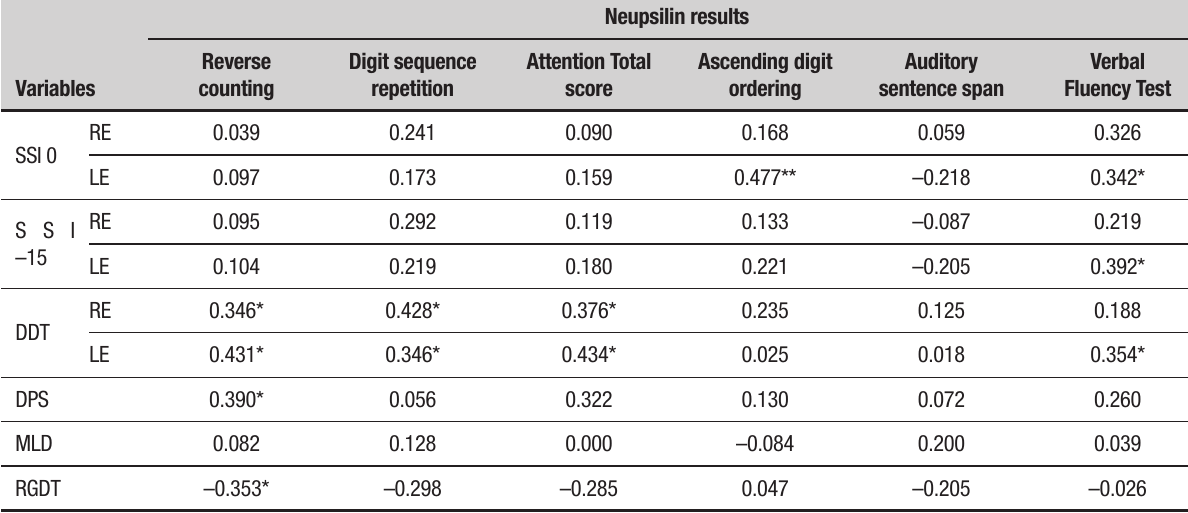
Table 3. Association between CAP tests and neuropsychological tests using the Spearman correlation